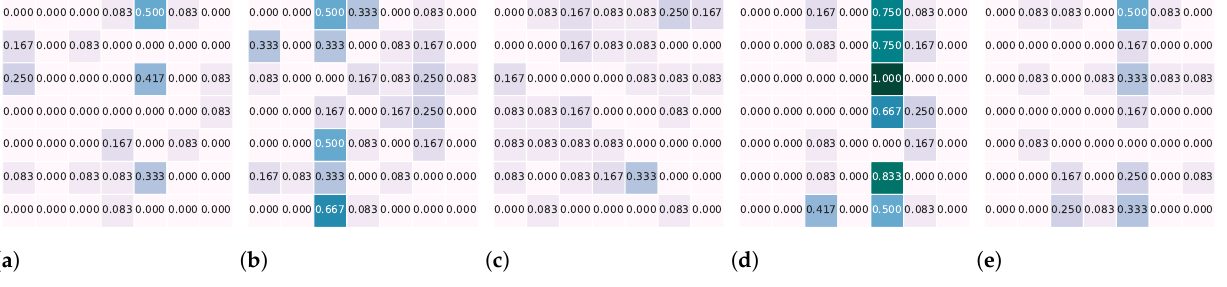
Figure 5. Illustration of the confusion matrices generated for humans, pre-trained (i.e., DeepFace and RMN) and fine-tuned (FT) models, for images distorted with Gaussian blur. Main diagonal elements were removed to better compare prediction errors. Lines correspond to ground truth labels, while columns represent predicted labels. Emotions are presented in alphabetical order, i.e., anger, disgust, fear, happiness, neutral, sadness, and surprise. ( a ) Humans; ( b ) DeepFace ( r = 0.33); ( c ) DeepFace FT ( r = 0.27); ( d ) RMN ( r = 0.67); ( e ) RMN FT ( r =